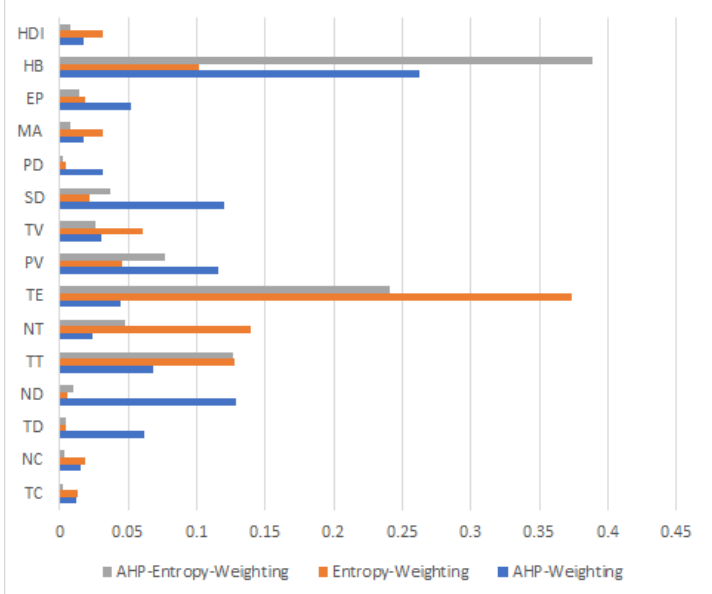
Figure 5. Indicators’ weights: AHP weighting, Entropy weighting and combined